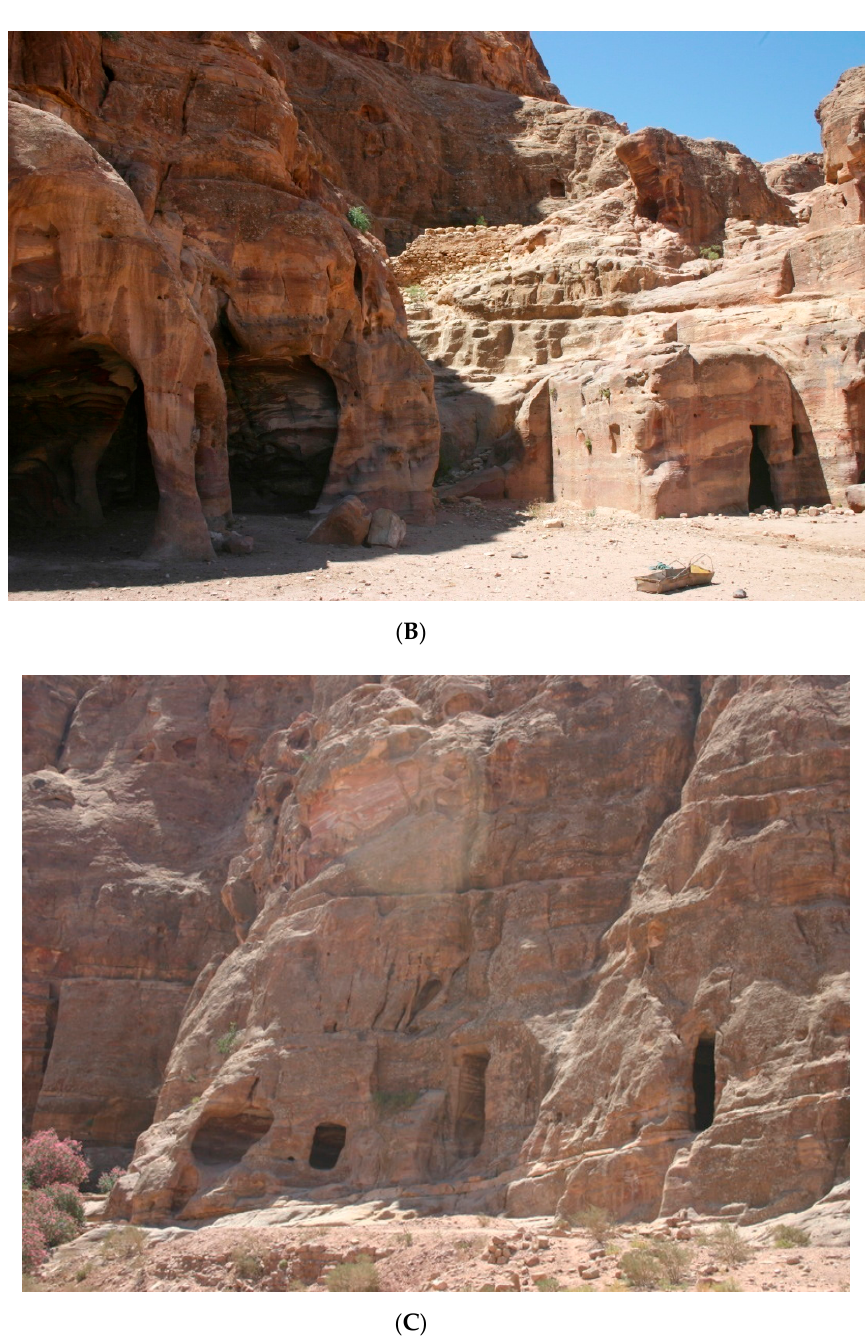
Figure 13. ( A ) The Wadi Mataha pipeline channel on the Jebel al Khubtha mountainside. ( B ) Continuation of the Wadi Mataha pipeline above the Sextus Florentinus Tomb (Figure 14). ( C ) Continuation of the Wadi Mataha channel is above workshop areas.